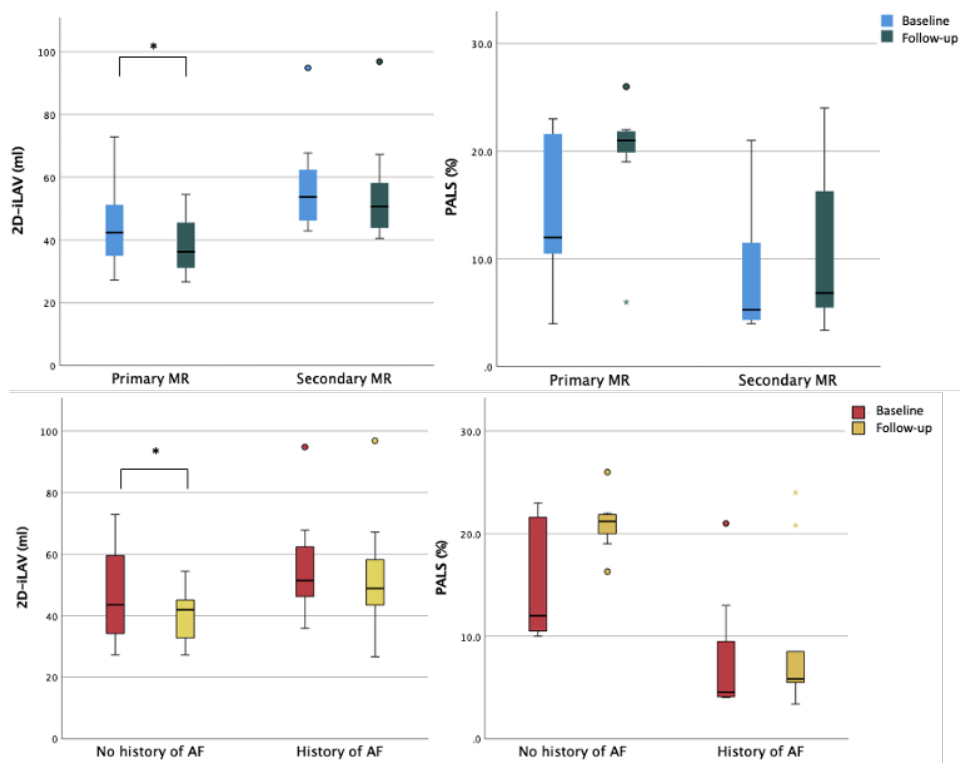
Figure 3. Ventricular and atrial remodeling after percutaneous mitral valve repair according to MR etiology. Legend: EPSPAP, estimated peak systolic pulmonary artery pressure; FAC, fractional area change; iLAV, indexed left atrial volume; iLVM, indexed left ventricular mass; iLVEDV, indexed left ventricular end-diastolic volume; iLVESV, indexed left ventricular end-systolic volume; LVEDD, left ventricular end-diastolic diameter; RA, right atrium; RVD, right ventricular diameter; RV GLS FW, right ventricle free wall longitudinal strain; TAPSE, tricuspid annular plane systolic excursion; TR, tricuspidal regurgitation. * = p < 0.05.